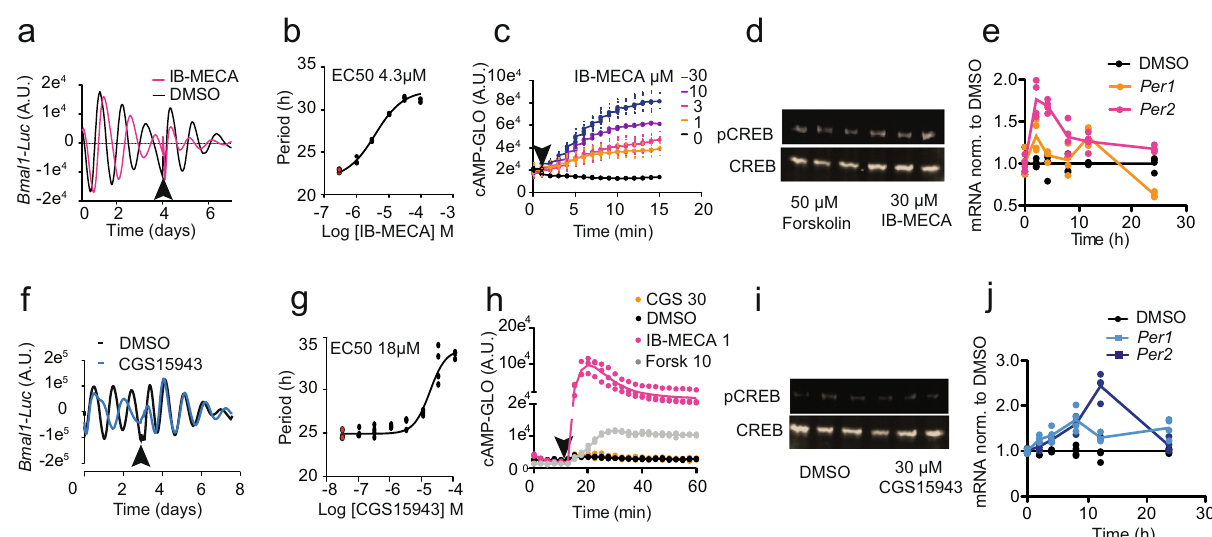
Fig. 1 Mechanisms of action of adenosine signalling to the clock. a 10 μ M IB-MECA increased period length in Bmal1- Luc U2OS cells which revert to normal rhythms after washout (arrow) in a concentration-dependent manner (traces are an average of n = 4) as shown in b ( n = 4, DMSO control samples in red); c IB-MECA increases cAMP levels (as monitored by the cAMP-GLO assay) in a concentration-dependent manner ( n = 6); d 30 µ M IB-MECA increases phosphorylation of CREB (pCREB S133) as shown by Western blot ( n = 3), Forskolin positive control; e PER1 and PER2 mRNA levels in U2OS cells increase after administration of 10 µ M IB-MECA ( n = 4, p < 0.001 with two-way ANOVA, p = 0.000074 at 2 h for PER1, and p = 0.00000000000021 and 0.000000024 at 2 h and 4 h for PER2, Š ídák ’ s multiple comparisons test). DMSO control in black. f 10 μ M CGS15943 (CGS) increased period length in Bmal1-Luc U2OS cells, which revert to normal rhythms after washout (arrow), in a concentration-dependent manner as shown in g , n = 4 DMSO control samples in red. h cAMP increases as monitored by the cAMP-GLO assay, CGS (30 µ M) administered at arrow, controls DMSO, 10 µ M Forskolin and IB-MECA 1 µ M shown, n = 3; i 30 µ M CGS did not increase phosphorylation of CREB as shown by Western blot ( n = 3). DMSO control shown; note d and i are part of the same blot, forskolin positive control. j PER1 and PER2 mRNA levels in U2OS increase after treatment with 10 µ M CGS ( n = 4, p = 0.03 for PER1 and p = 0.0006 for PER2 with two-way ANOVA). DMSO control in